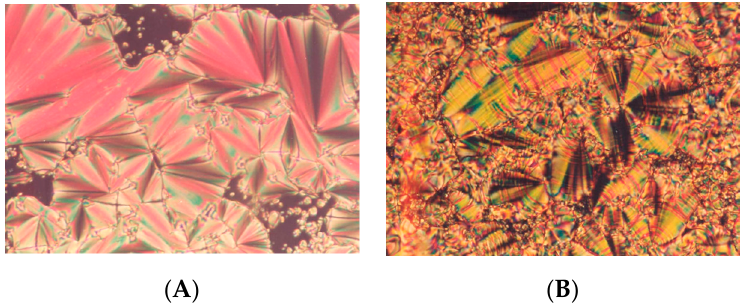
Figure 3. Optical polarizing micrographs displayed by polymer 14P upon cooling from the isotropic phase. ( A ) The smectic A focal-conic texture obtained at 172.6 °C (320×). ( B ) The smectic E banded focal-conic texture obtained at 152.2 °C (320×). Table 2. Phase transition temperature and thermodynamic parameters of polymers 1P ~ 18P .